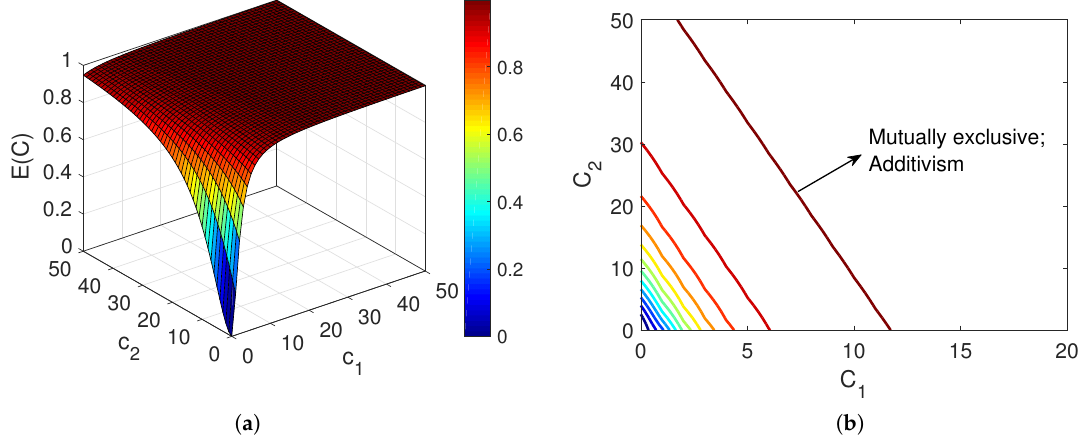
Figure 2. Combination of mutually exclusive agents: ( a ) The effect versus dosage of the combining agents; ( b ) Dosage of drug 2 versus drug 1 with respect to the combination effect which represents